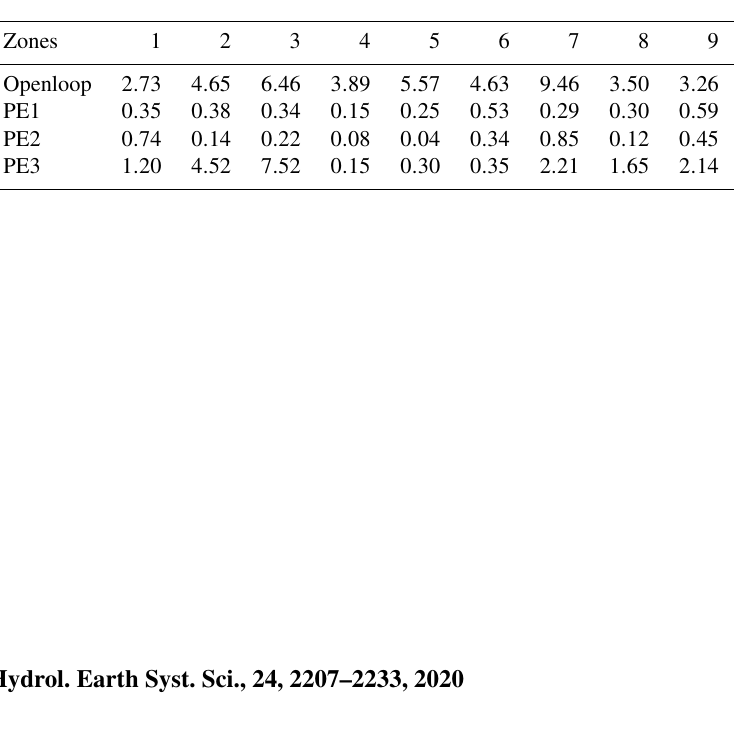
Table D2. Zone-averaged RMSEn for the openloop discharges (row 2) and the ensemble-averaged analysis discharges (rows 3–5) compared to the true